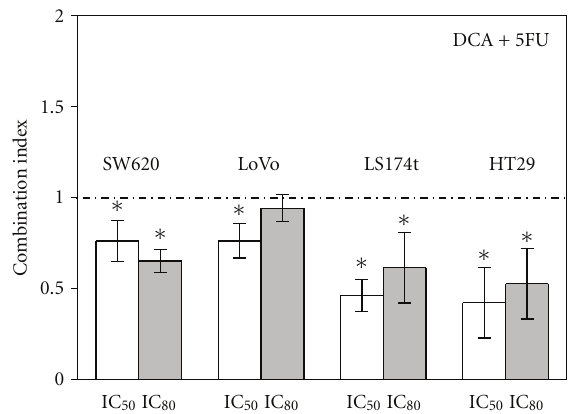
Figure 2: Mean values of the combination index at the a ff ected fractions of 50% (IC 50 ) and 80% (IC 80 ) when 5-fluoruracil (5-FU) was combined with dichloroacetate (DCA) in HT-29, LoVo, LS174t, and SW620 cells. Mean IC 50 and IC 80 ± SD ( n = 3) are shown. A CI value significantly less than 1 indicates synergism, a CI not significantly di ff erent from 1 indicates addition, and a CI signifi- cantly higher than 1 indicates antagonism; ∗ P < . 05.